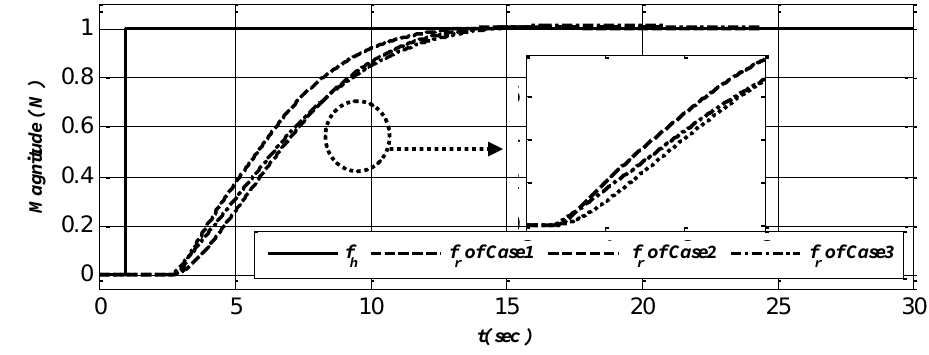
Figure 9a. Force tracking for step input (Human operator F h and reflected force F r )